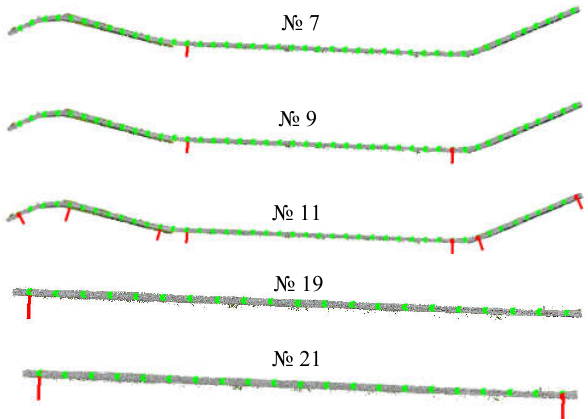
Figure 6. Schemes of placing control points for generating photogrammetric models 7, 9, 11, 19,